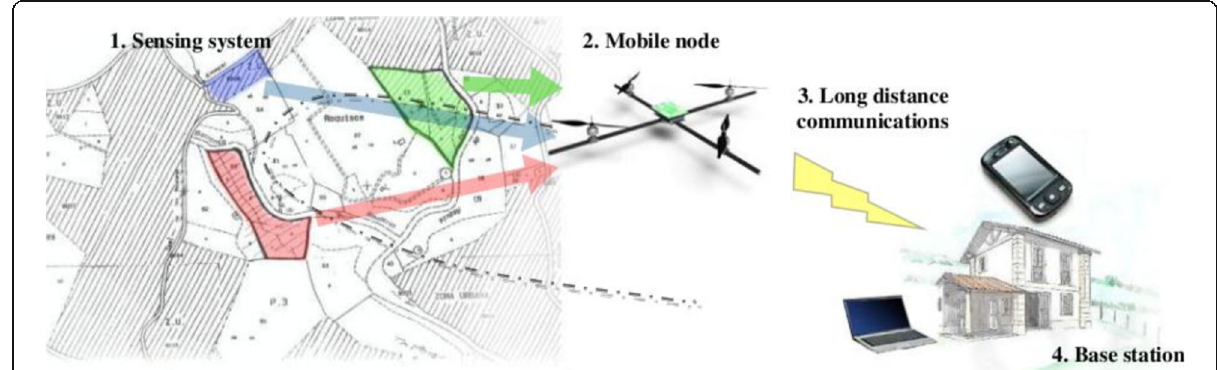
Fig. 1 An illustrative example of the overall remote sensing mission. The system layout on the package is shown in Fig.